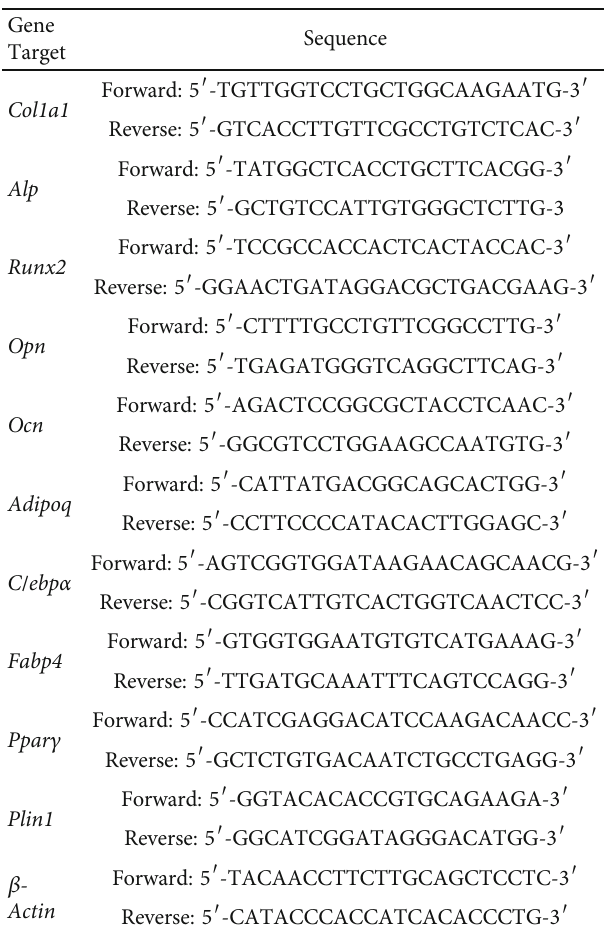
Table 1: Primer sequences used in quantitative real-time reverse transcription polymerase chain